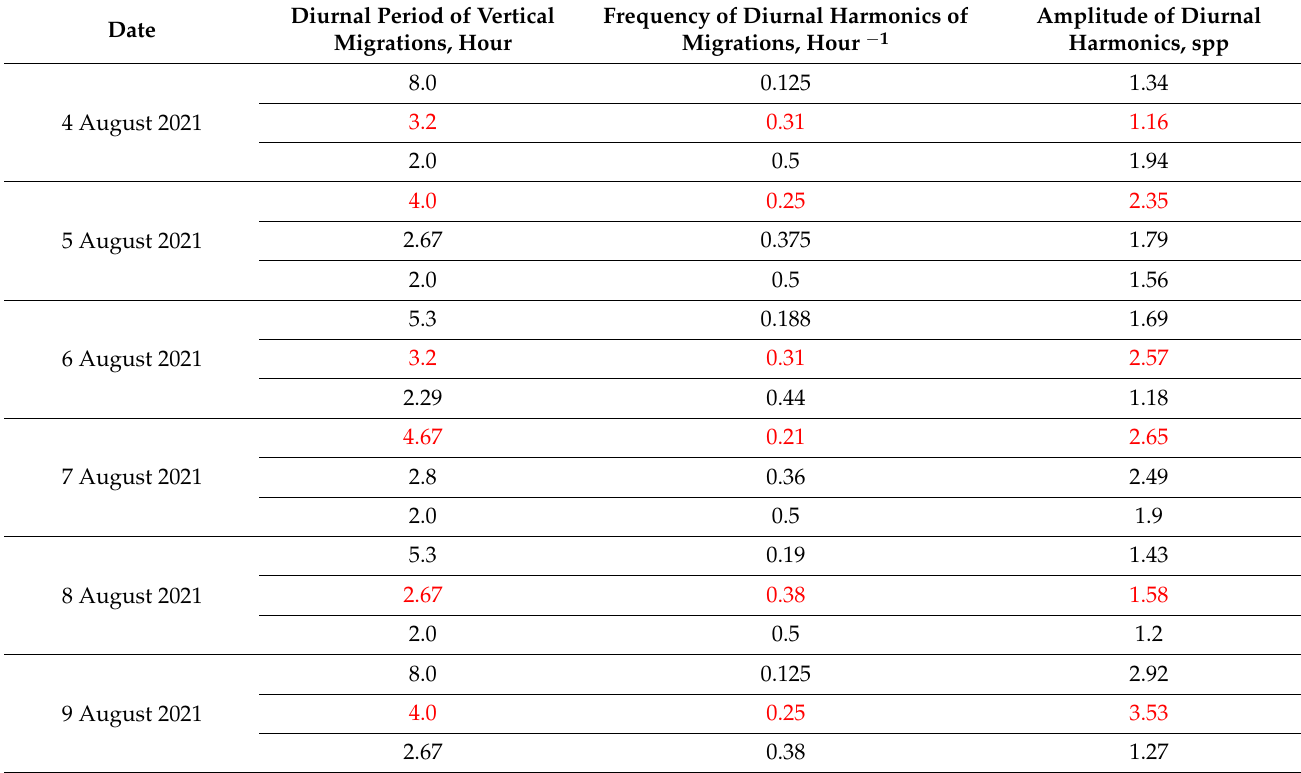
Table 3. Results of the Fourier analysis of daily time functions over 6 days of moorage. Red color shows the diurnal components of the spectrum and their characteristics with the level of significance p ≤